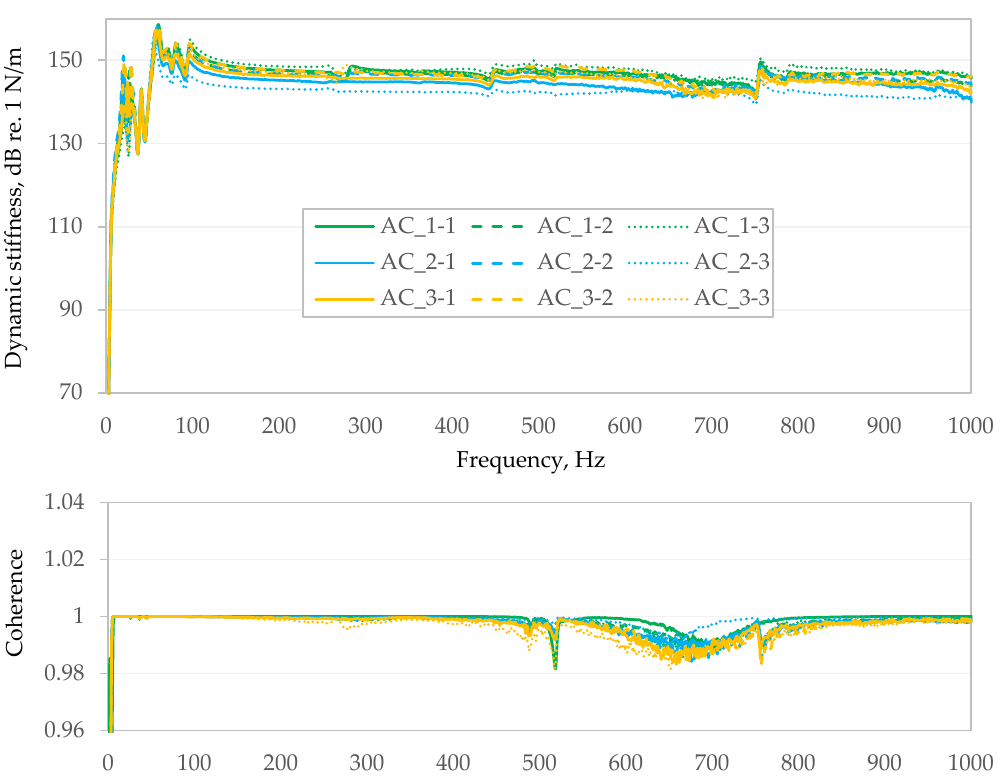
Figure 5. Dynamic stiffness ( top ) and coherence ( bottom ) of the E1 mixture.